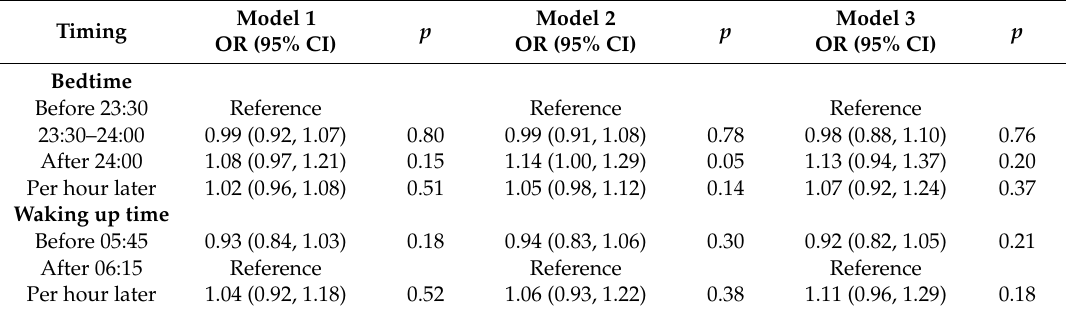
Table 4. Prospective association between sleep timing and change in BMI Z-score ( n = 468).